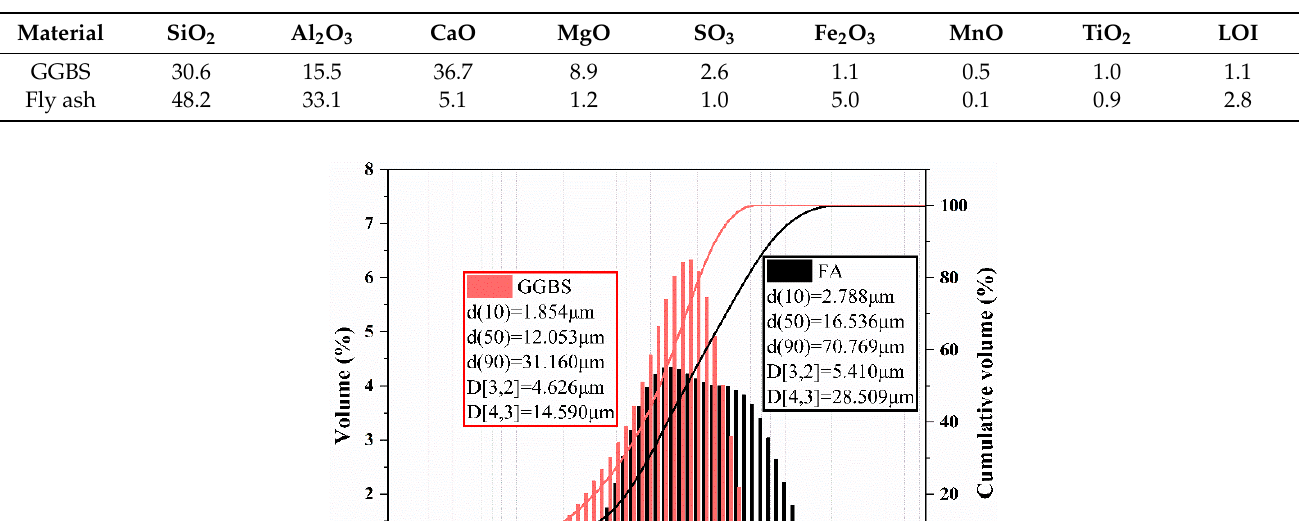
Table 1. Chemical composition of cementitious materials (wt.%).